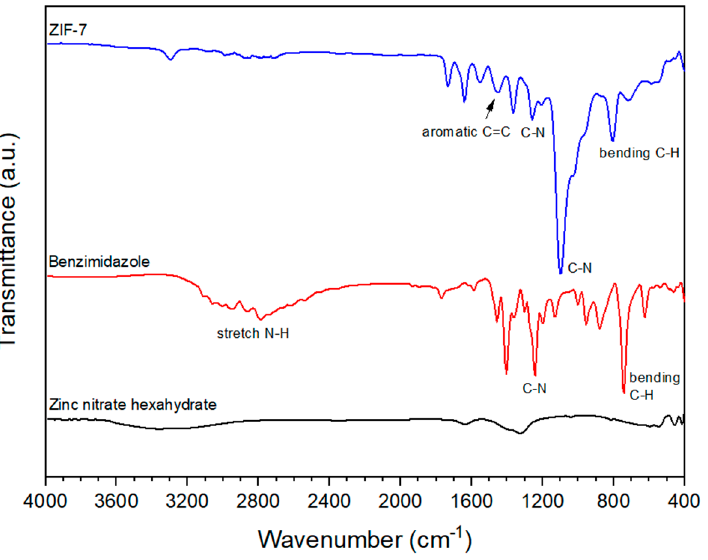
Figure 2. FT − IR spectra of zinc nitrate hexahydrate, benzimidazole, and ZIF ‐ 7.